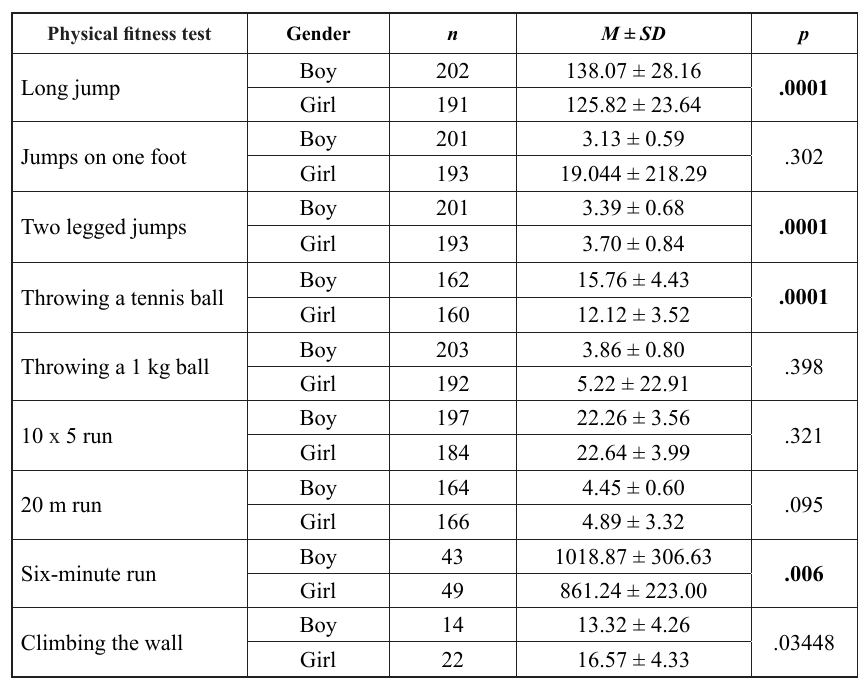
Table 2. Distribution of school- children’s physical fitness assess - ment mean results by gender